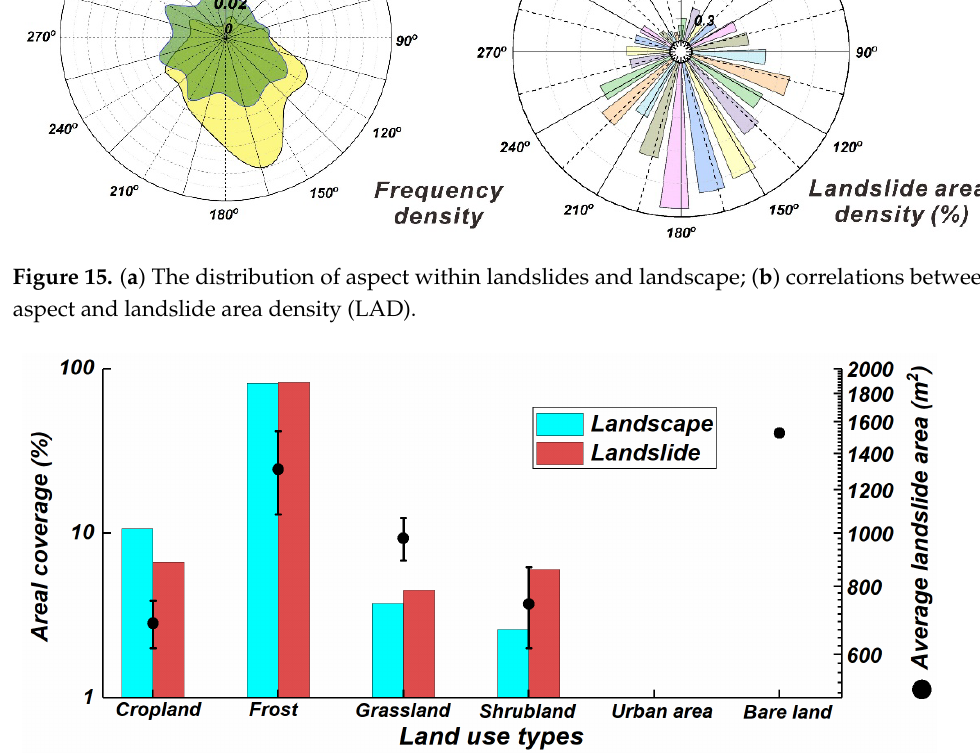
Figure 15. ( a ) The distribution of aspect within landslides and landscape; ( b ) correlations between aspect and landslide area density (LAD).